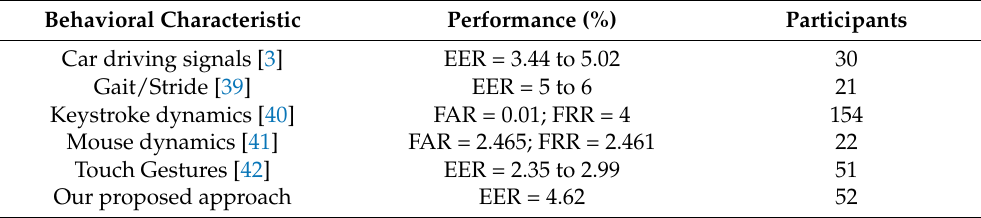
Table 5. Summary of the EERs of user authentication using various behavioral